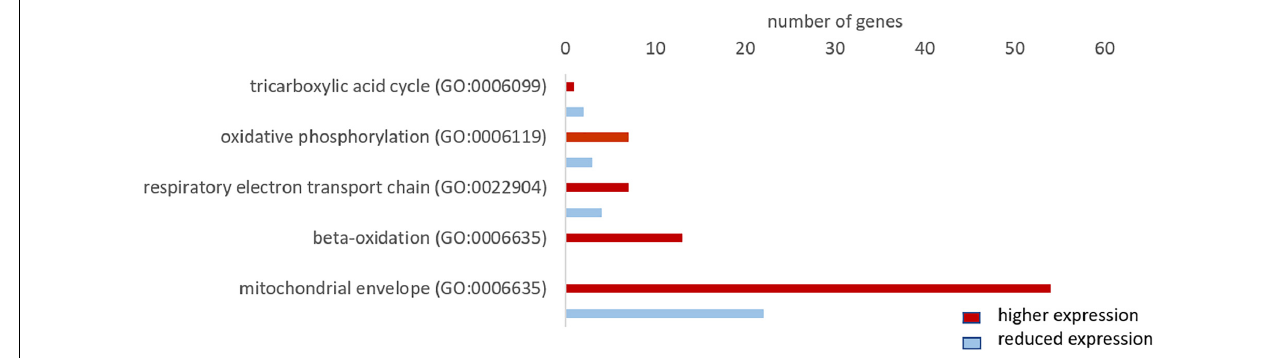
FIGURE 9 | Total number of genes related to aerobic metabolism with a higher (red) and lower expression (blue) in whale brains compared to the cattle. Only genes differentially expressed (fold change ≥ 2, range ≥ 5, RPKM ≥ 1 and FDR-corrected p -value ≤ 0.05) were considered.